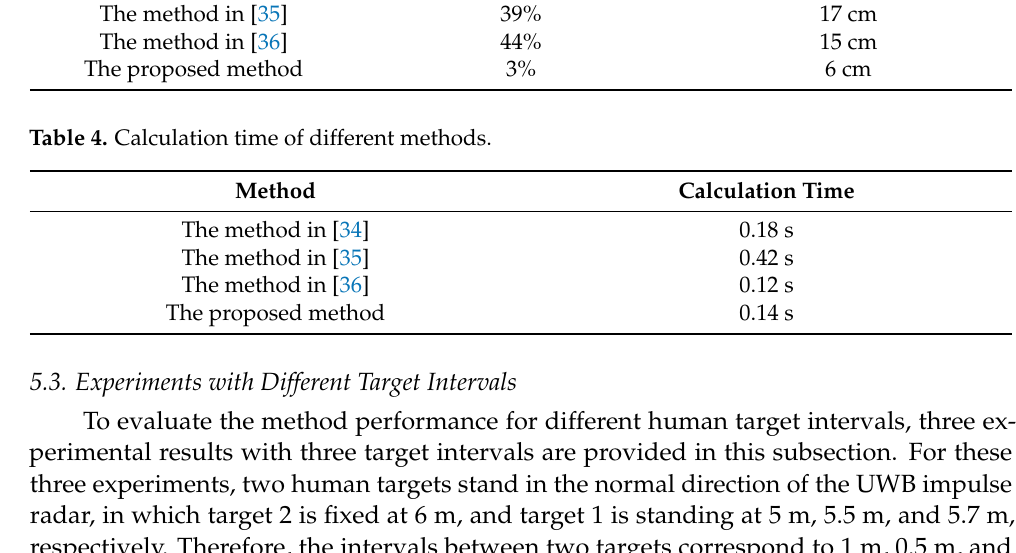
Table 4. Calculation time of different methods.